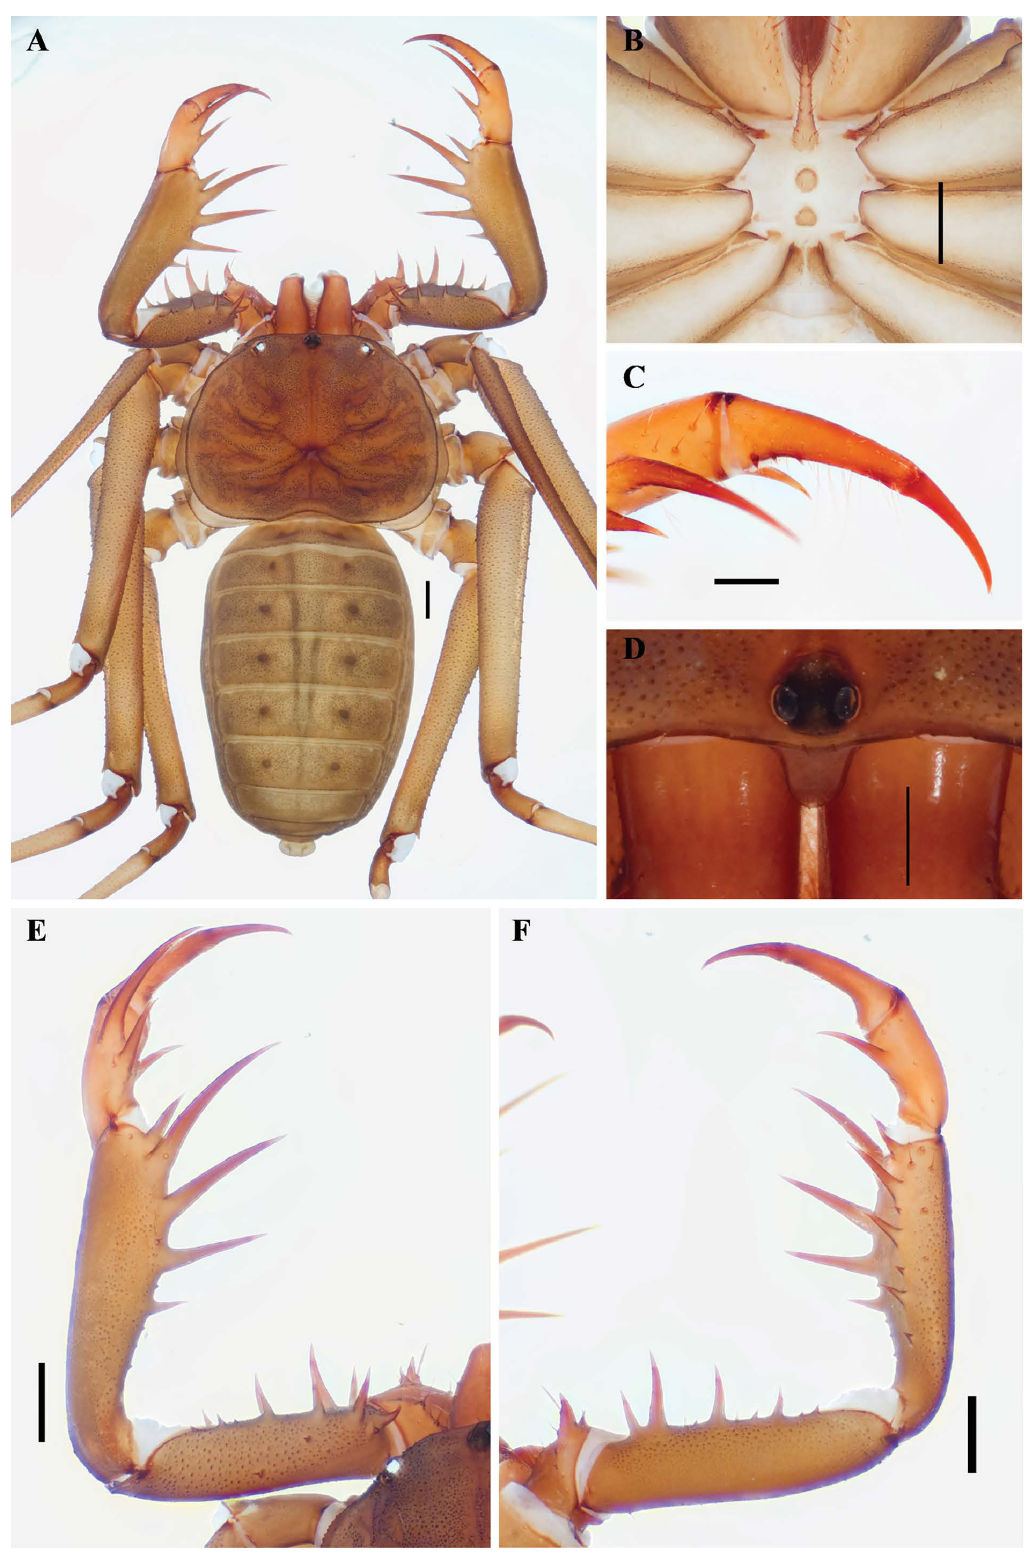
Fig. 151. Weygoldtia consonensis sp. nov. (AMNH), general morphology, ♀. A . Habitus, dorsal view. B . Sternum, ventral view. C . Frontal process. D . Pedipalp, dorsal view. F . Pedipalp, ventral view. Scale bars: A–B, E–F = 1 mm; C–D = 0.5